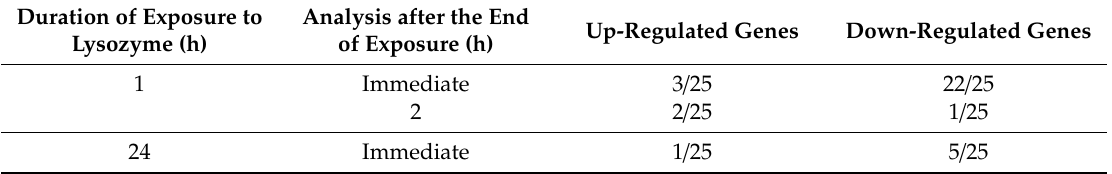
Table 1. Comparison of the number of genes di ff erentially expressed in U937 cells following lysozyme